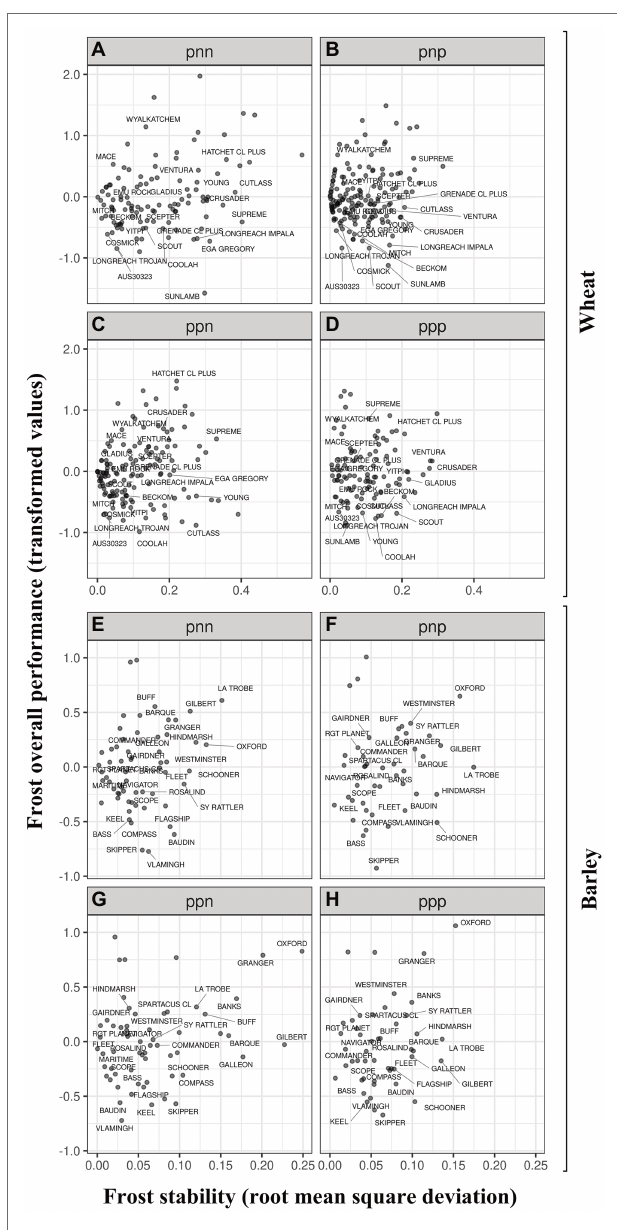
FIGURE 3 | Frost overall performance (OP, frost transformed values) as a function of frost stability for wheat (A–D) and barley (E–H) . OP between different I-classes for wheat and barley are presented in panels (A-H) , respectively. The I-classes are labeled with a three-character code (one for each factor), where each character is either “p” or “n” (for positive or negative loadings). For example, the I-class labeled “pnp” contains all experiments that had positive loadings in the first and third factors and negative loadings in the second factor. The FEEs within I-classes are presented in Table 6